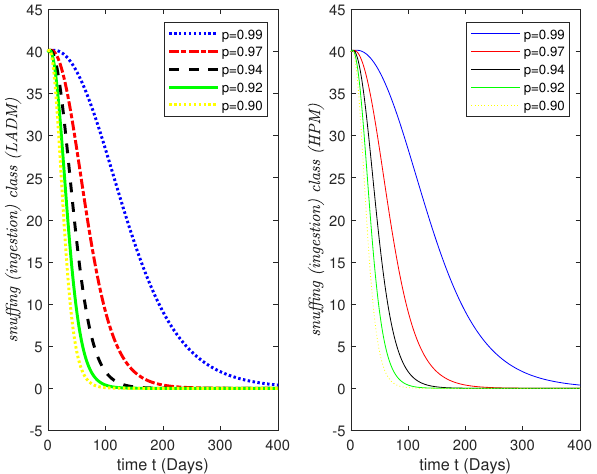
Figure 8. Comparison of the approximate solution for H ( t ) class of the proposed model at different arbitrary fractional orders by LADM and HPM.